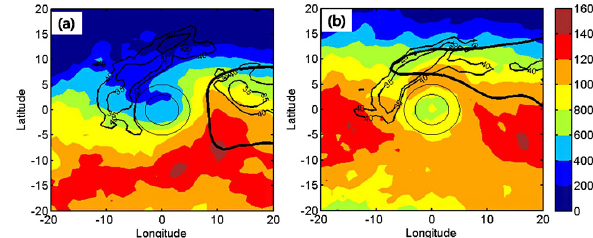
Figure 13. GFS-derived fields for the composites of CAPE (shad- ing) and geopotential height of 5880m at 500hPa (thick black line) for (left) weakening and (right) strengthening events at time t + 48h . Black contours are drawn at 40 and 35% 500hPa RH. The two black solid circles are 3 ◦ - and 5 ◦ -radius circles centered on the